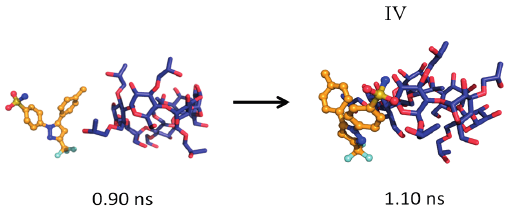
Figure 5. The formation of the 1:1 CCB/HP- β -CD association complex (Structure IV).